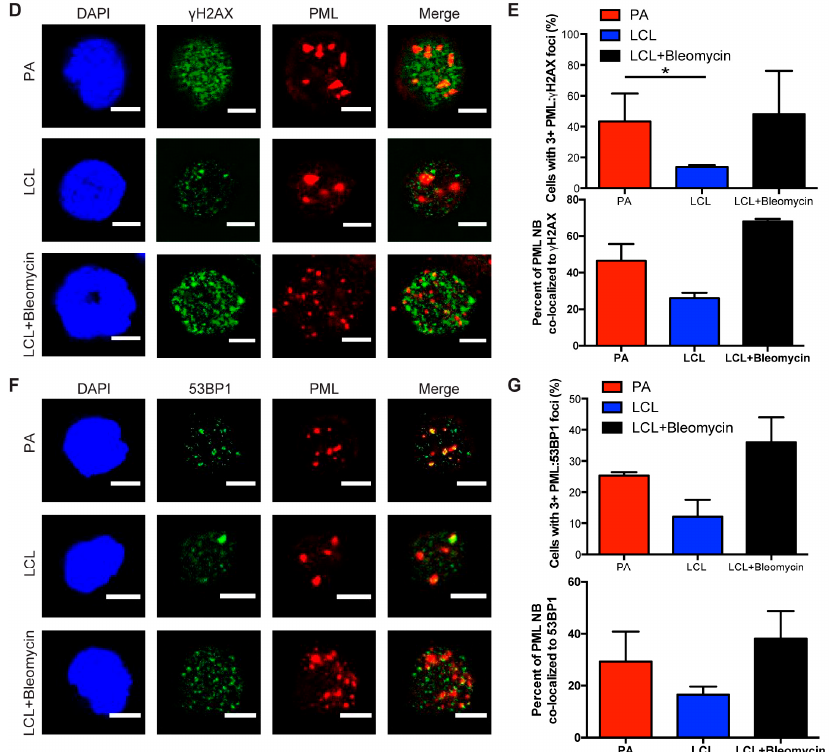
Figure 1. Persistent DNA damage foci increase in arrested EBV-infected B cells. ( A ) Schematic demonstrating infection, staining and sorting protocol to separate early, hyper-proliferating and then arrested (PA) cell populations from proliferating populations (PP), along with the generation of immortalized LCLs. ( B ) Immunofluorescence (IF) of PML NBs (red) and DAPI (blue) measured from sorted arrested B cells (PA), LCLs, and bleomycin-treated LCLs. ( C ) Quantification of PML NB foci per nucleus from ( A ). Error bars represent SD of three independent donors. *** p < 0.001 as determined by a Mann-Whitney test. ( D ) IF of γ H2AX (green), PML NBs (red), and DAPI (blue) measured from sorted arrested B cells, LCLs, and bleomycin-treated LCLs. Co-localization of γ H2AX-PML is shown in Merge. ( E ) Upper, quantification of cells with three or more PML NBs co-localized with γ H2AX per nucleus from ( D ). Lower, quantification of percent γ H2AX co-localization with PML per cell from ( D ). Error bars represent S.E.M of three independent donors for PA and LCL and two donors for LCL plus bleomycin. * p < 0.05, *** p < 0.001 as determined by a Student’s t -test. ( F ) IF of 53BP1 (green), PML NBs (red), and DAPI (blue) measured from sorted arrested B cells, LCLs, and bleomycin-treated LCLs. Co-localization of 53BP1-PML is shown in Merge. Note: the single, large 53BP1 focus co-localizing with PML is likely an Oct-1, PTF, transcription (OPT) domain [37]. ( G ) Upper, quantification of cells with three or more PML NBs co-localized with 53BP1 per nucleus from ( F ). Lower, quantification of percent 53BP1 co-localized with PML per cell from ( F ). Error bars represent S.E.M. of two independent donors. All scale bars indicate 5 μ m.